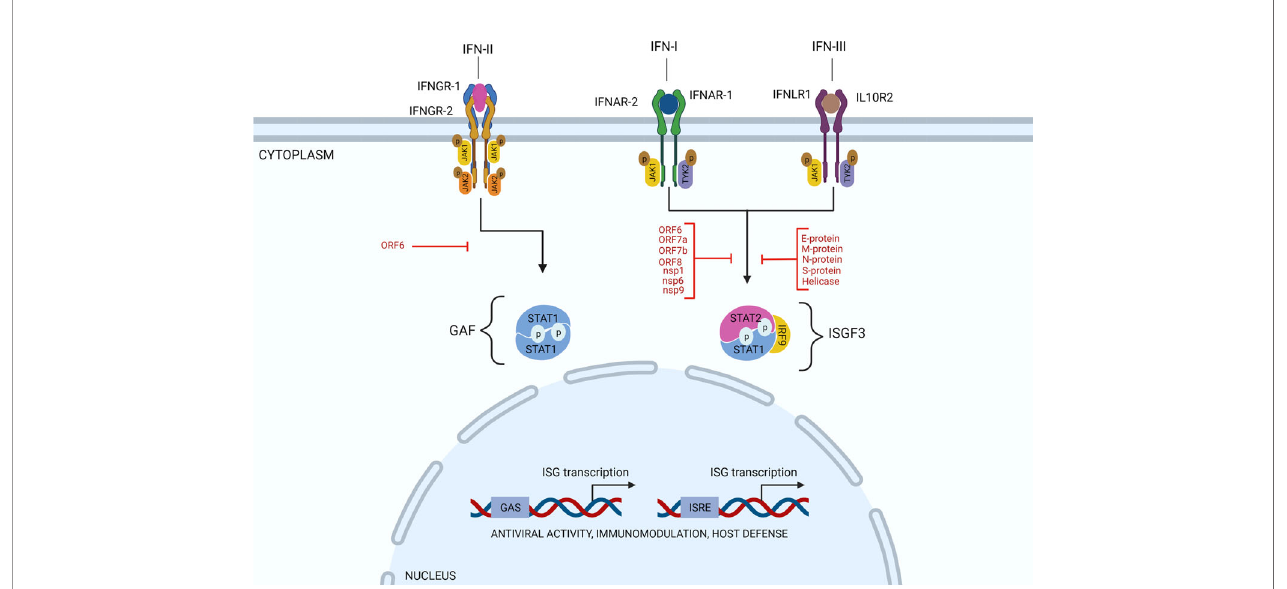
FIGURE 2 | SARS-CoV-2 evolved strategies to target IFN signaling. Through binding to their cognate cellular receptors and Janus kinase (JAK)-dependent phosphorylation, IFNs activate transcription factors of the Signal Transducer and Activator of Transcription (STAT) family and expression of IFN-stimulated genes (ISG)s. Thus, IFN-I, IFN-II, and IFN-III induce ISG expression by phosphorylating STAT1 and/or STAT2. IFN-II-induced STAT1 homodimers regulate gene expression of IFN-II activation site (GAS) containing genes. The association of IRF9 with STAT1/2 heterodimers (known as ISGF3), expands the range of enhancer elements targeted by IFN-I and IFN-III to IFN-stimulated response element (ISRE). Various SARS-CoV-2 proteins, as indicated (in red), have been identi fi ed to inhibit the IFN response. Particularly, by interfering with STAT1 and/or STAT2 activation and ISG expression, as explained in the